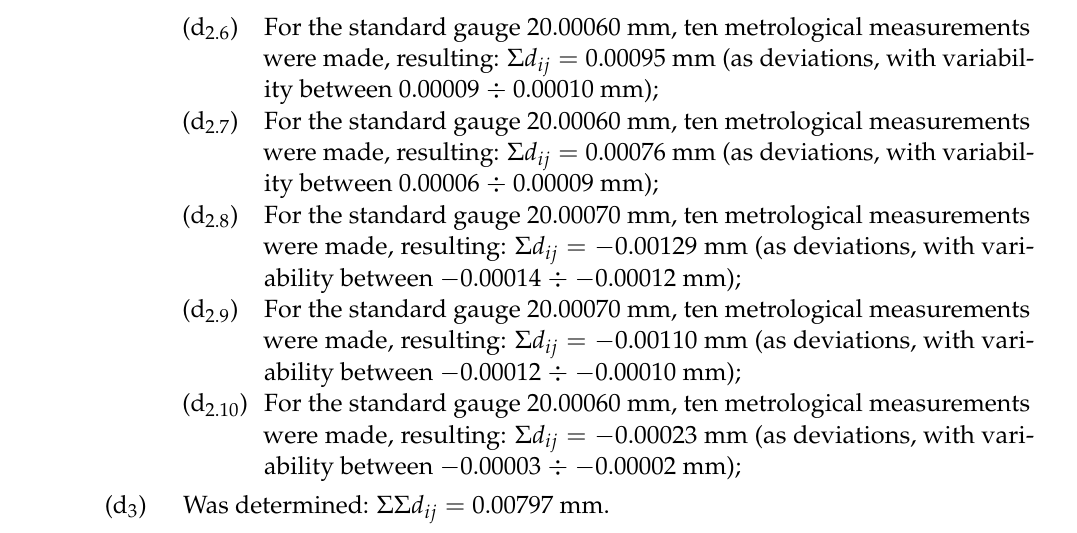
Table 5. Protocol of metrological measurements for determination of metrological values